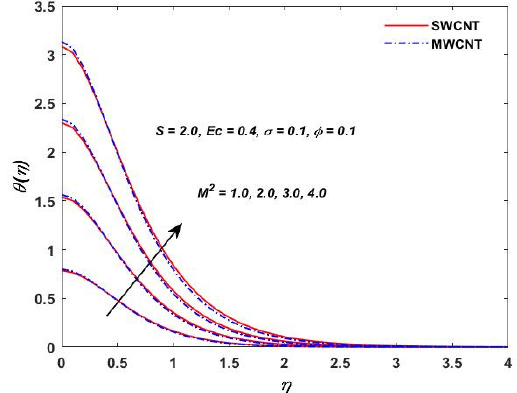
Figure 11. 𝑀 (cid:2870) verses 𝜃(𝜂). Figure 11. M 2 verses θ ( η ) .